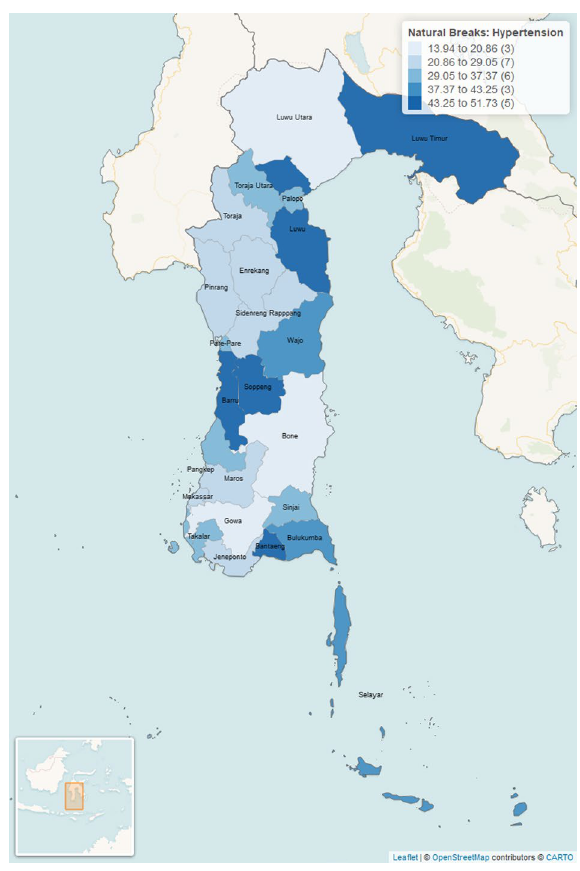
Figure 3. Prevalence rate of hypertension in the 2017–2018 period in South Sulawesi Province. The number in the parentheses indicated the number of districts/cities. This figure was generated by using R Basic version: 4.2.2 (https:// cran.r- proje ct. org/ bin/ windo ws/ base/) and R Studio Desktop version: 2022.07.2 + 576 (https:// posit. co/ downl oad/ rstud io- deskt op/) for windows operating system. We also utilized several packages to produce this figure such as sf package (https://r- spati al. github. io/ sf/), dplyr package (https:// github. com/ tidyv erse/ dplyr), rgdal package (http:// rgdal.r- forge.r- proje ct. org/), tmap package (https:// github. com/r- tmap/ tmap) and leaflet package (https:// rstud io. github. io/ leafl et/). The details of city covered in this figure are listed as follows: (13.94 to 20.86): Luwu Utara, Gowa, Bone (3 districts/cities). (20.86 to 29.05): Toraja, Enrekang, Pinrang, Sidenreng Rappang, Maros, Makassar, Jeneponto (7 districts/cities). (29.05 to 37.37): Toraja Utara, Palopo, Pare-pare, Pangkep, Sinjai, Takalar (6 districts/cities). (37.37 to 43.25): Wajo, Bulukumba, Selayar (3 districts/cities). (43.25 to 51.73): Luwu Timur, Luwu, Soppeng, Barru, Bantaeng (5 districts/cities).